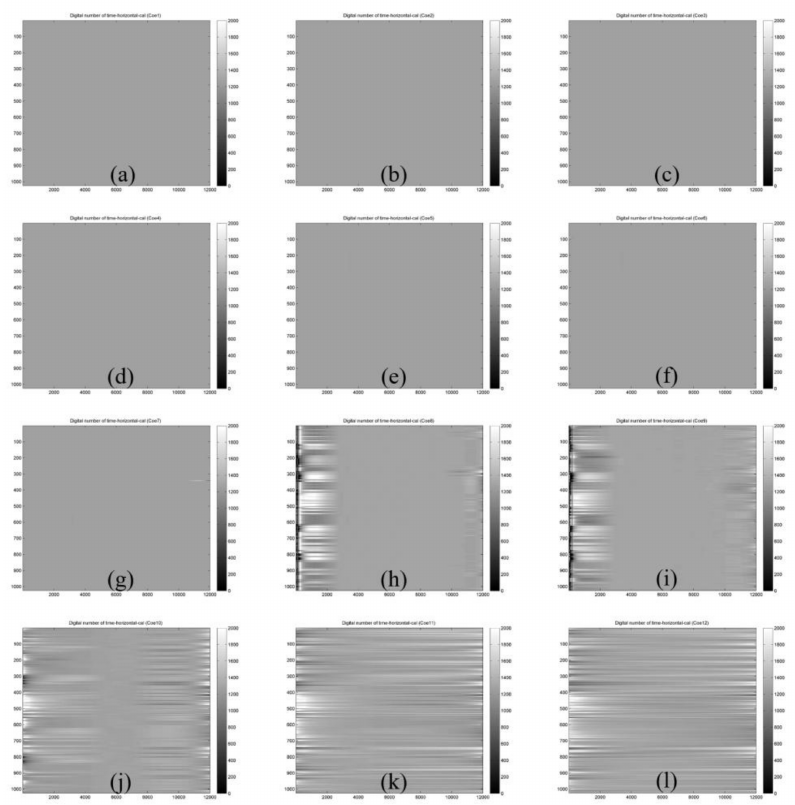
Figure 9. Results of IMF filtering on digital mode test imagery. ( a – l ) indicate the resulting IMF-filtered imagery after deducting various numbers ( x ) of accumulative IMFs (i.e., x = 1, 2, 3, . . . , 12; x is an integer, representing the number of accumulative IMFs) from the original test imagery as described in Equation